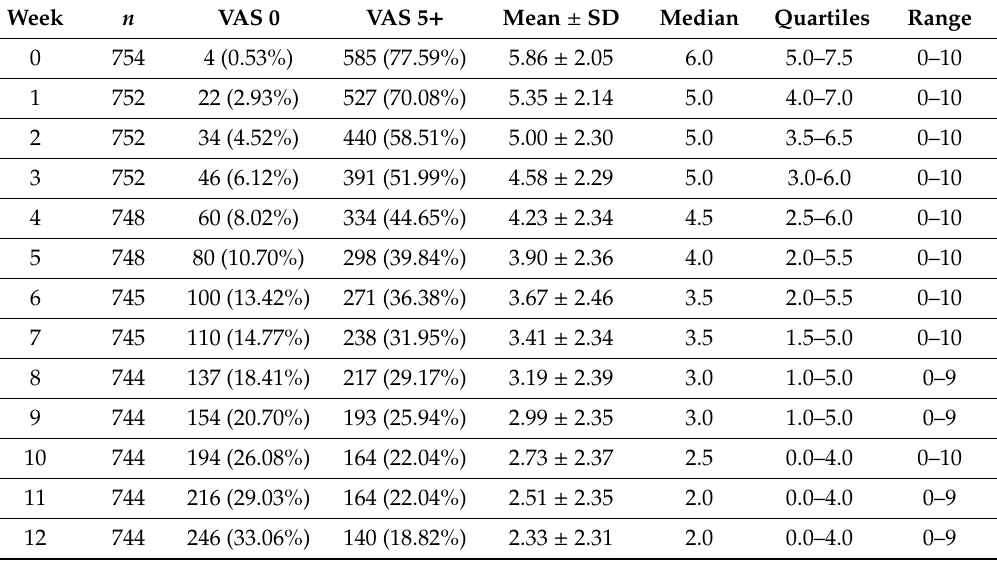
Table 2. Statistical characteristics of pain severity during consecutive control